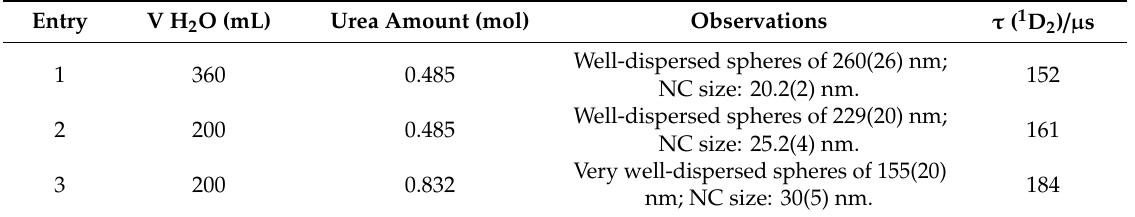
NCs synthesized by homogeneous precipitation method.